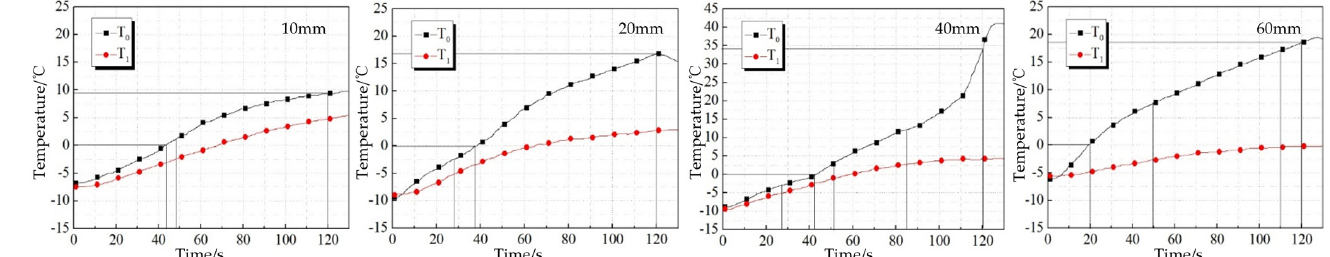
Figure 7. Temperature curves of specimens at different heating heights over time.